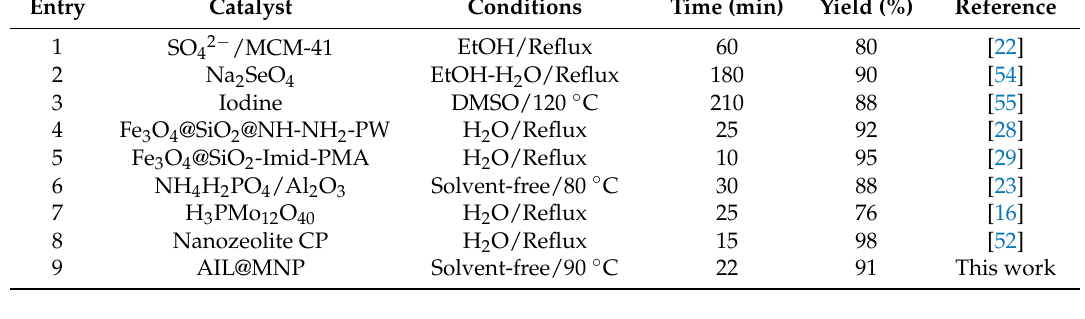
Comparison of different catalysts for the one-pot three-component reaction of 4-chlorobenzaldehyde, malononitrile and dimedone.